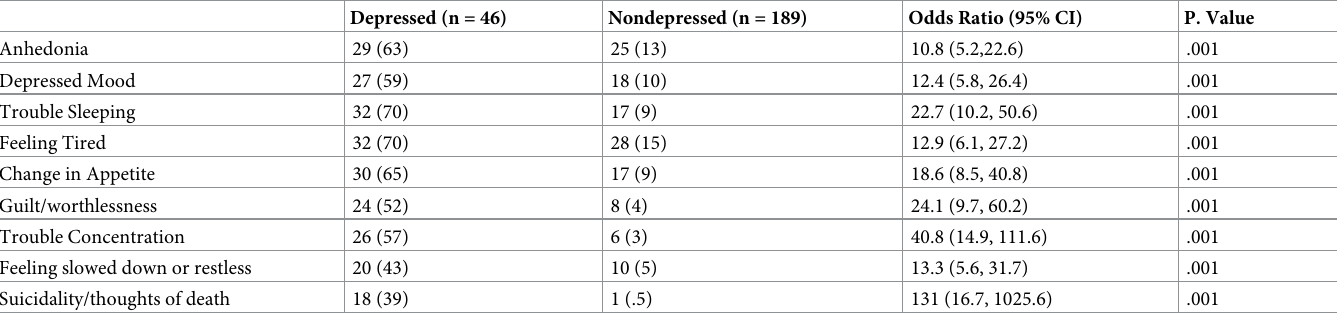
Table 3. Frequency (%) of stroke patients endorsing each PHQ-9 symptom more than half the days or every